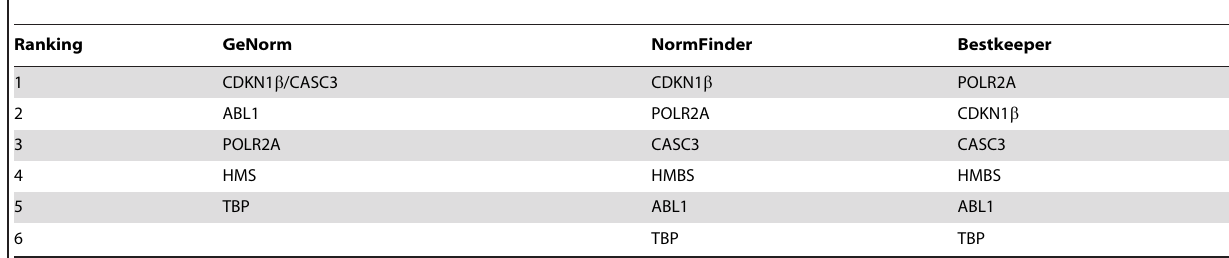
Table 5. Ranking of reference genes according to GeNorm, NormFinder and Bestkeeper algorithms.